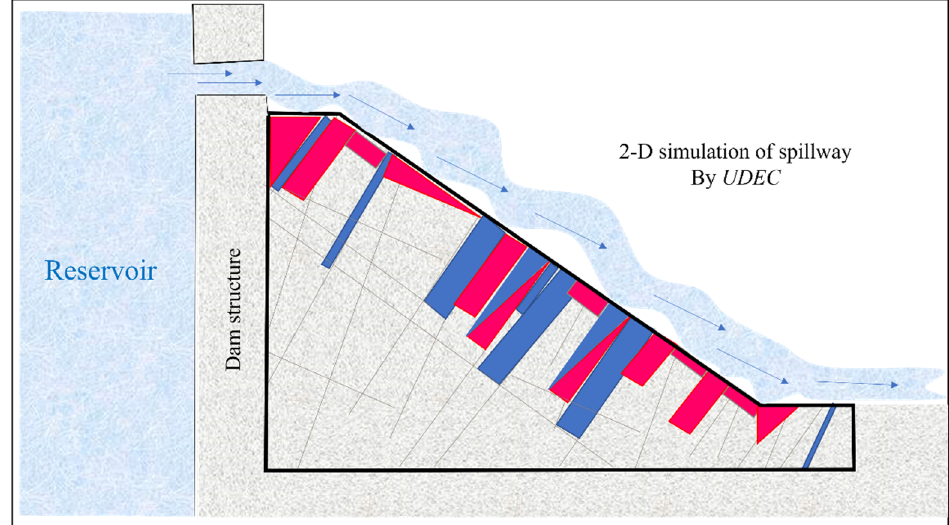
Figure 18. Two-dimensional ejectable blocks in an unlined spillway [88].